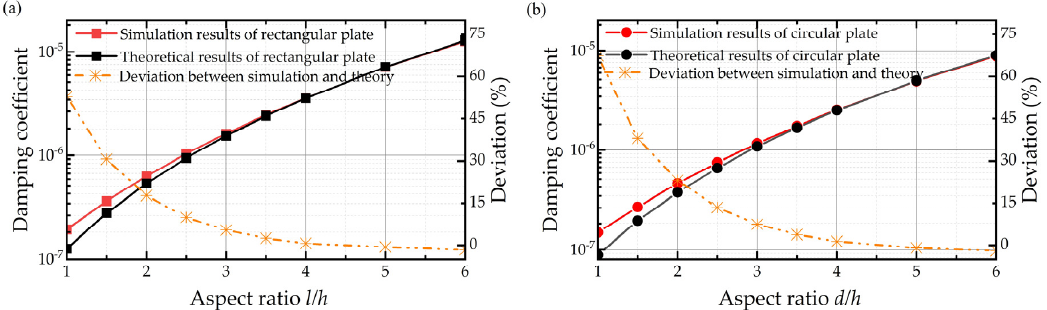
Figure 8. Damping coefficients of the simulation results and theoretical results and deviations between them for the ( a ) rectangular plate and ( b ) circular plate considering both the finite size effect and border effect when the air film thickness is 0.6 mm.